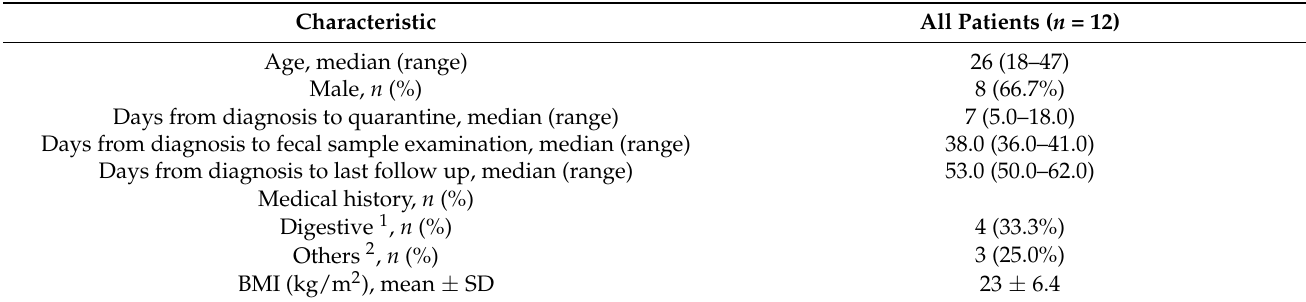
Table 1. Clinical characteristics of enrolled